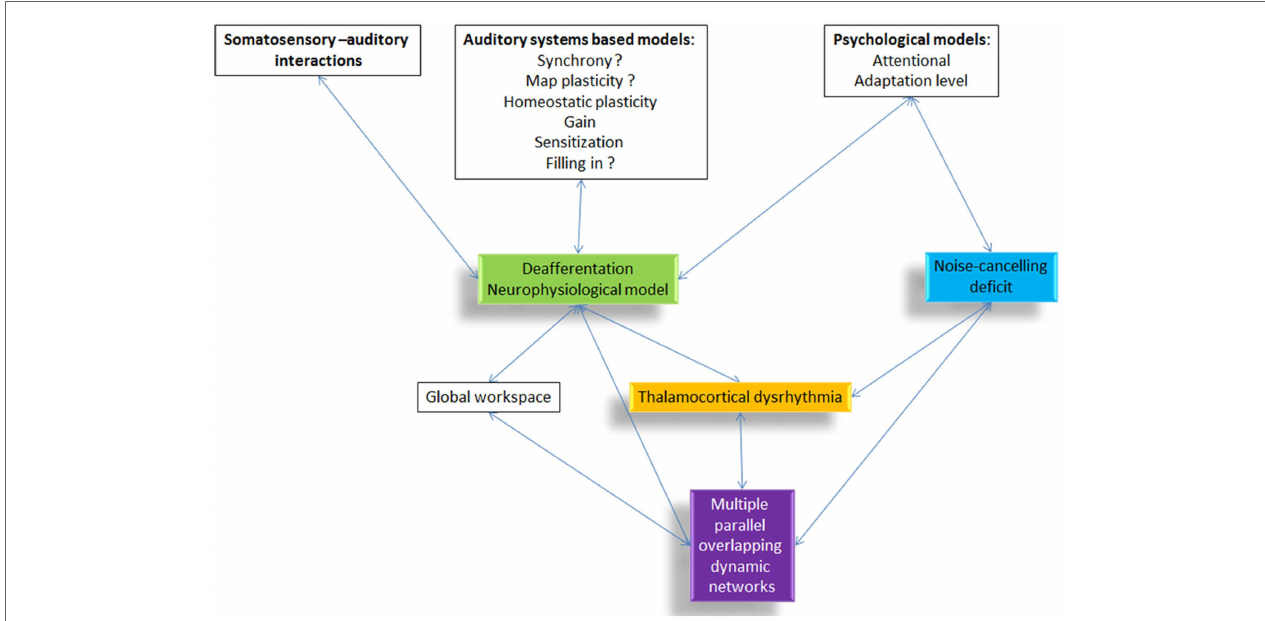
FiGuRe 1 | Overview of the different tinnitus models and how they are related to each other . All proposed pathophysiological models include or relate to thalamocortical